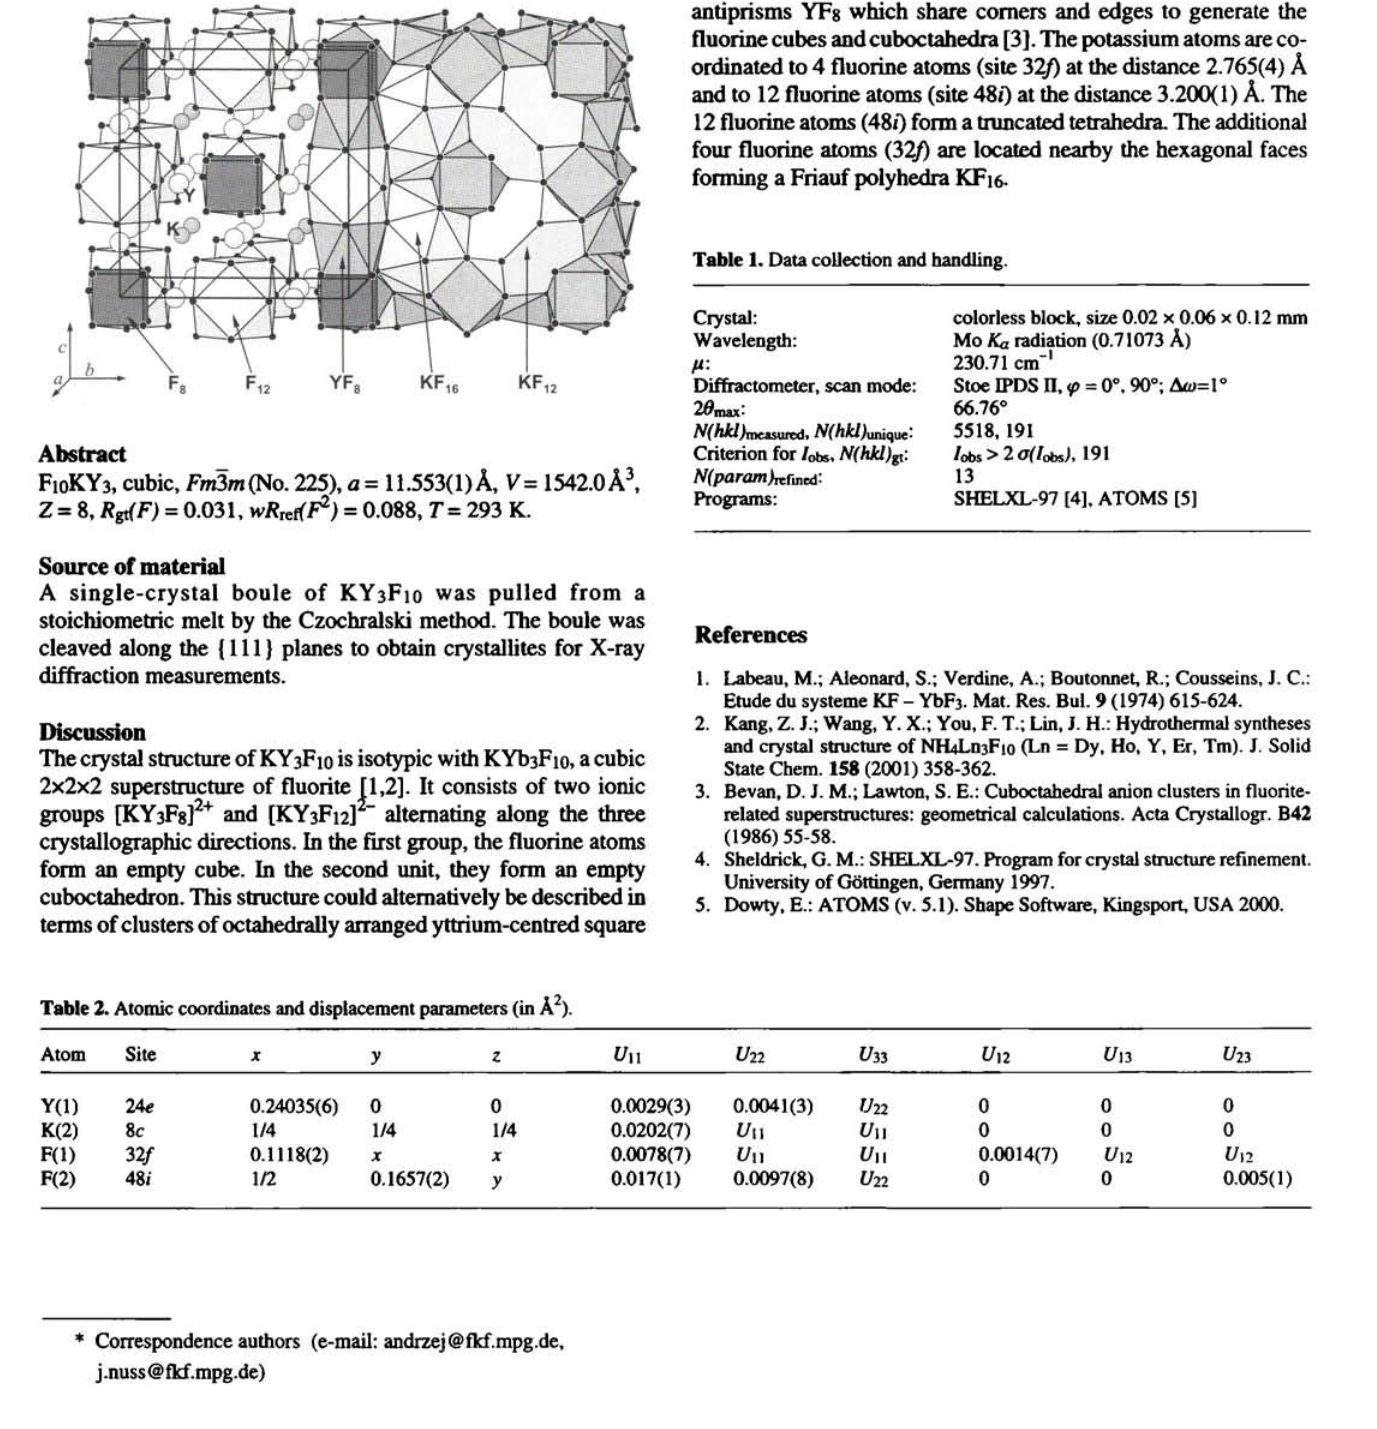
Table 2. Atomic coordinates and displacement parameters (in Â 2